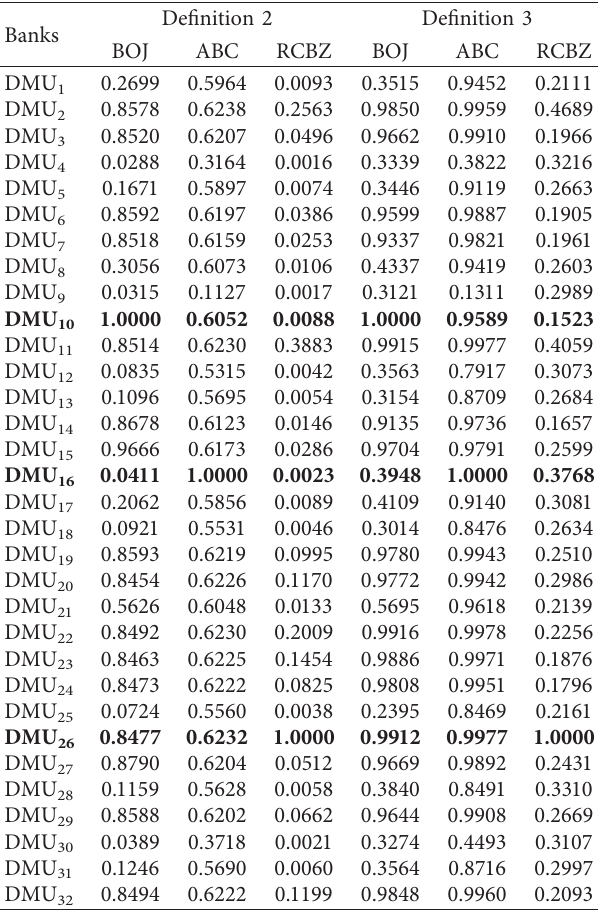
Table 5: Two kinds of dominating probabilities for BOJ, ABC, and RCBZ in